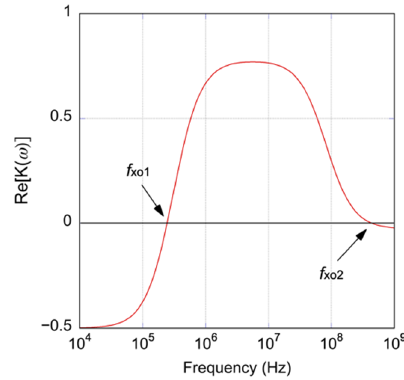
Figure 1. Typical frequency response of Re[𝐾(𝜔)] . 𝑓 (cid:2934)(cid:2925)(cid:2869) and 𝑓 (cid:2934)(cid:2925)(cid:2870) are the crossover frequencies.